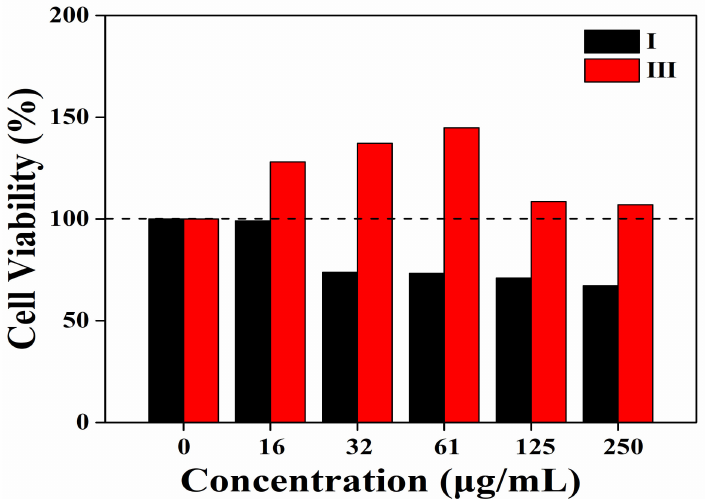
Figure 4. The cell viabilities of L-929 fibroblasts cultured in medium with the nanofibres of di ff erent